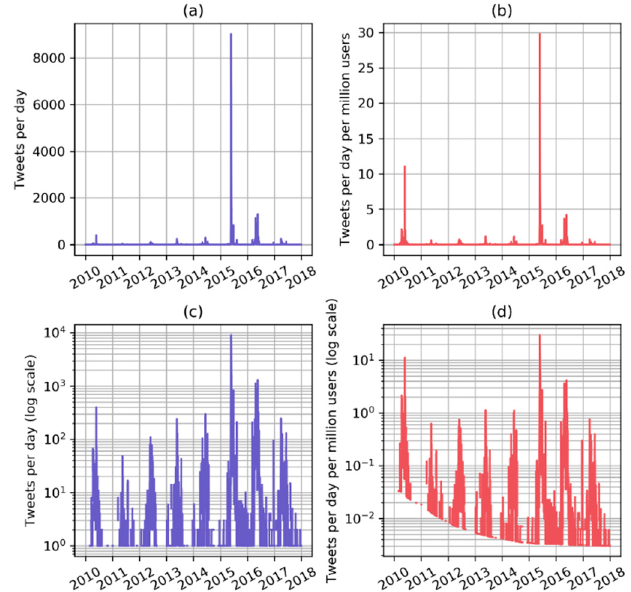
Figure 3. Time series of daily tweets regarding heat waves in India are plotted in panel ( a ) and in panel ( c ) using a logarithmic scale. In panel ( b ) time series of daily tweets are scaled by the number of Twitter users globally and the same time series is plotted in panel ( d ) in logarithmic scale.